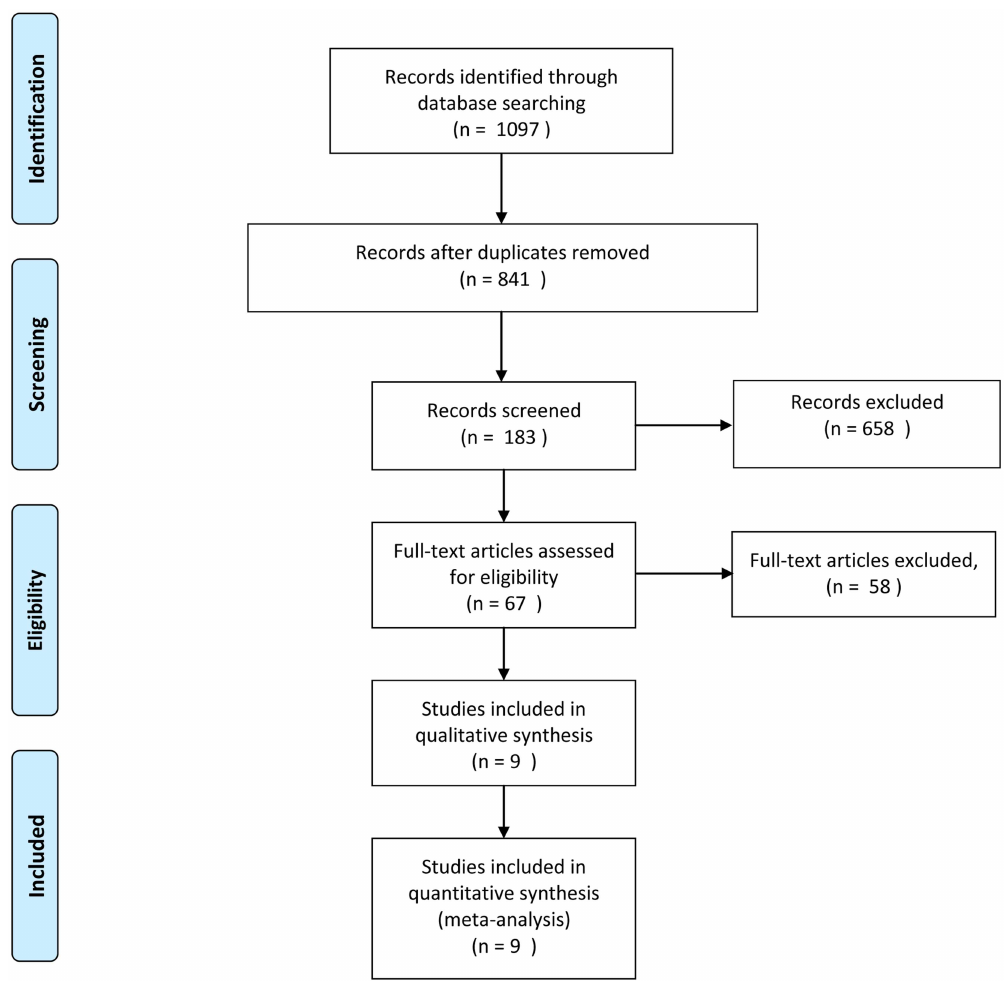
Fig 1. Flow diagram sketchesthe literatures identified, screened, included and excluded in